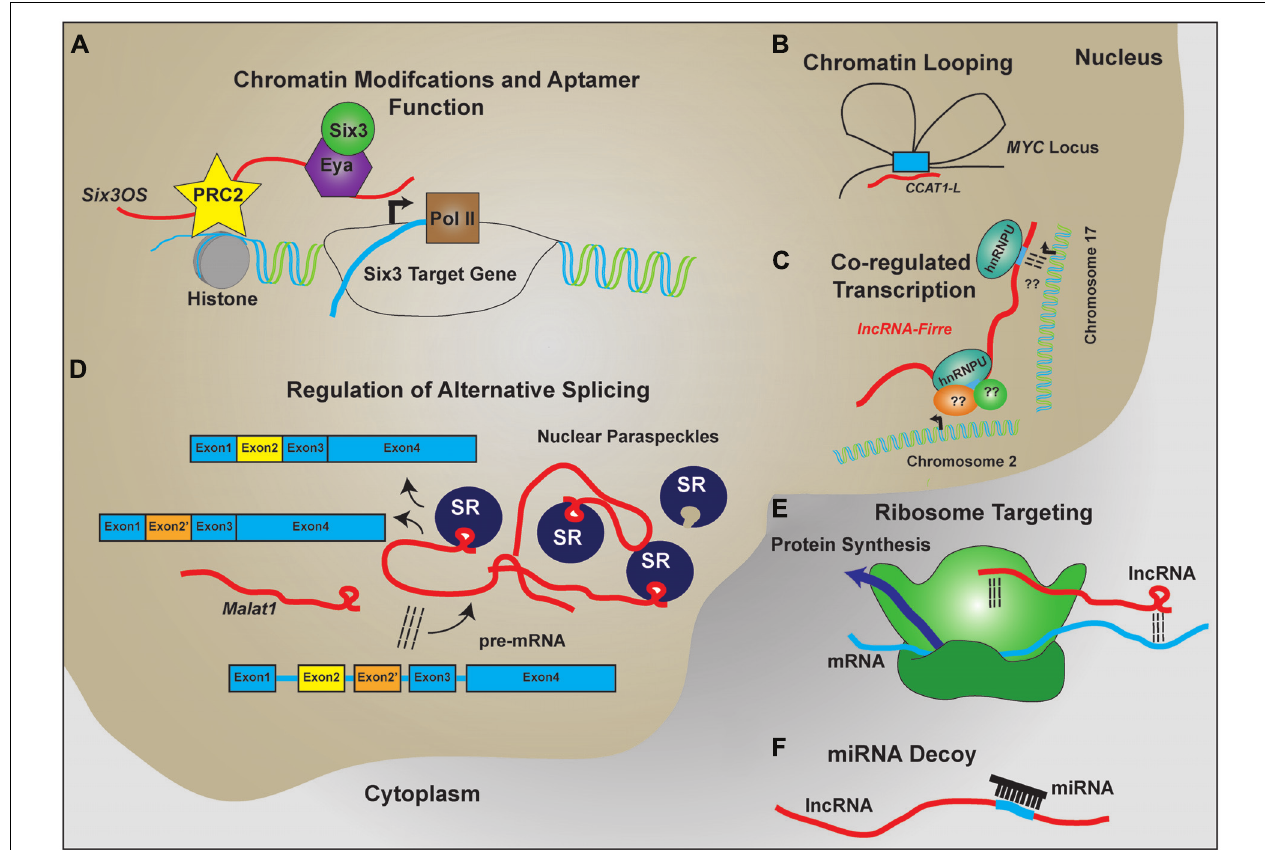
contain repeat sequences for protein binding help facilitate co-regulated transcription of multiple targets, including transcription across different chromosomes. (D) LncRNAs are implicated in the formation and maintenance of nuclear paraspeckles that facilitate alternative splicing events of nascent transcripts. (E) Through homologous base-pairing with mRNA transcripts and interactions with ribosomal proteins and/or RNAs, lncRNAs are able to target mRNAs to the ribosomes. (F) Containing complementary target sequences, lncRNAs also serve as miRNA decoys to prevent interactions of miRNAs with protein-coding